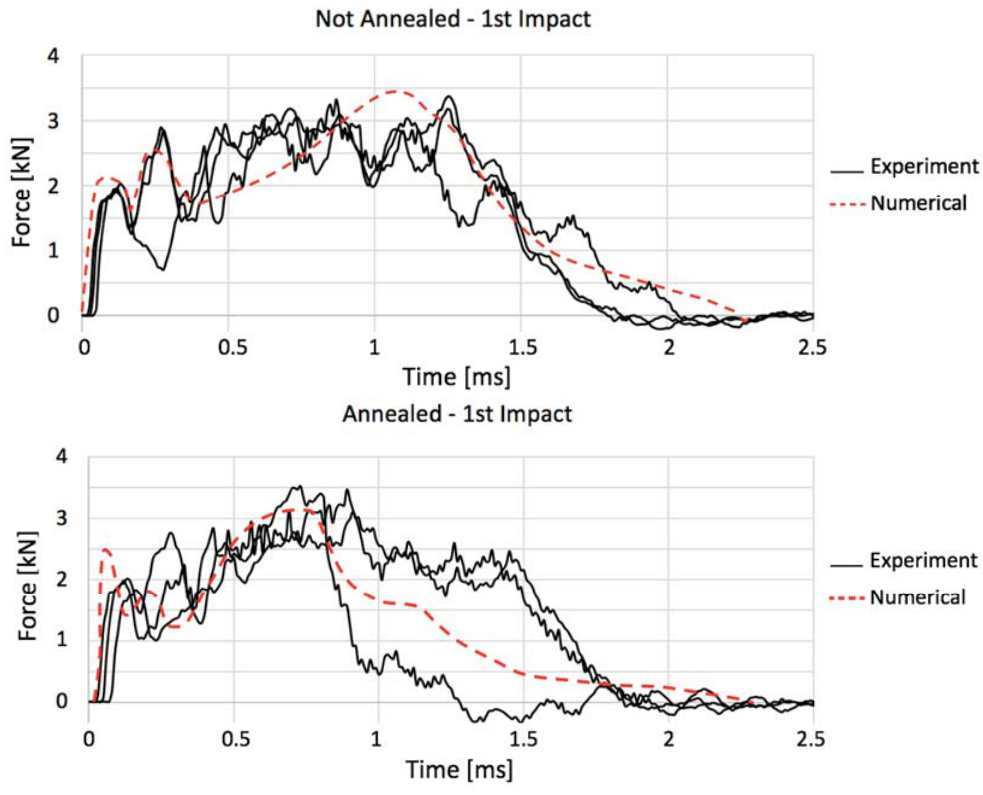
Figure 15. Confrontation of numerical and experimental curves for not annealed and annealed porcelain.